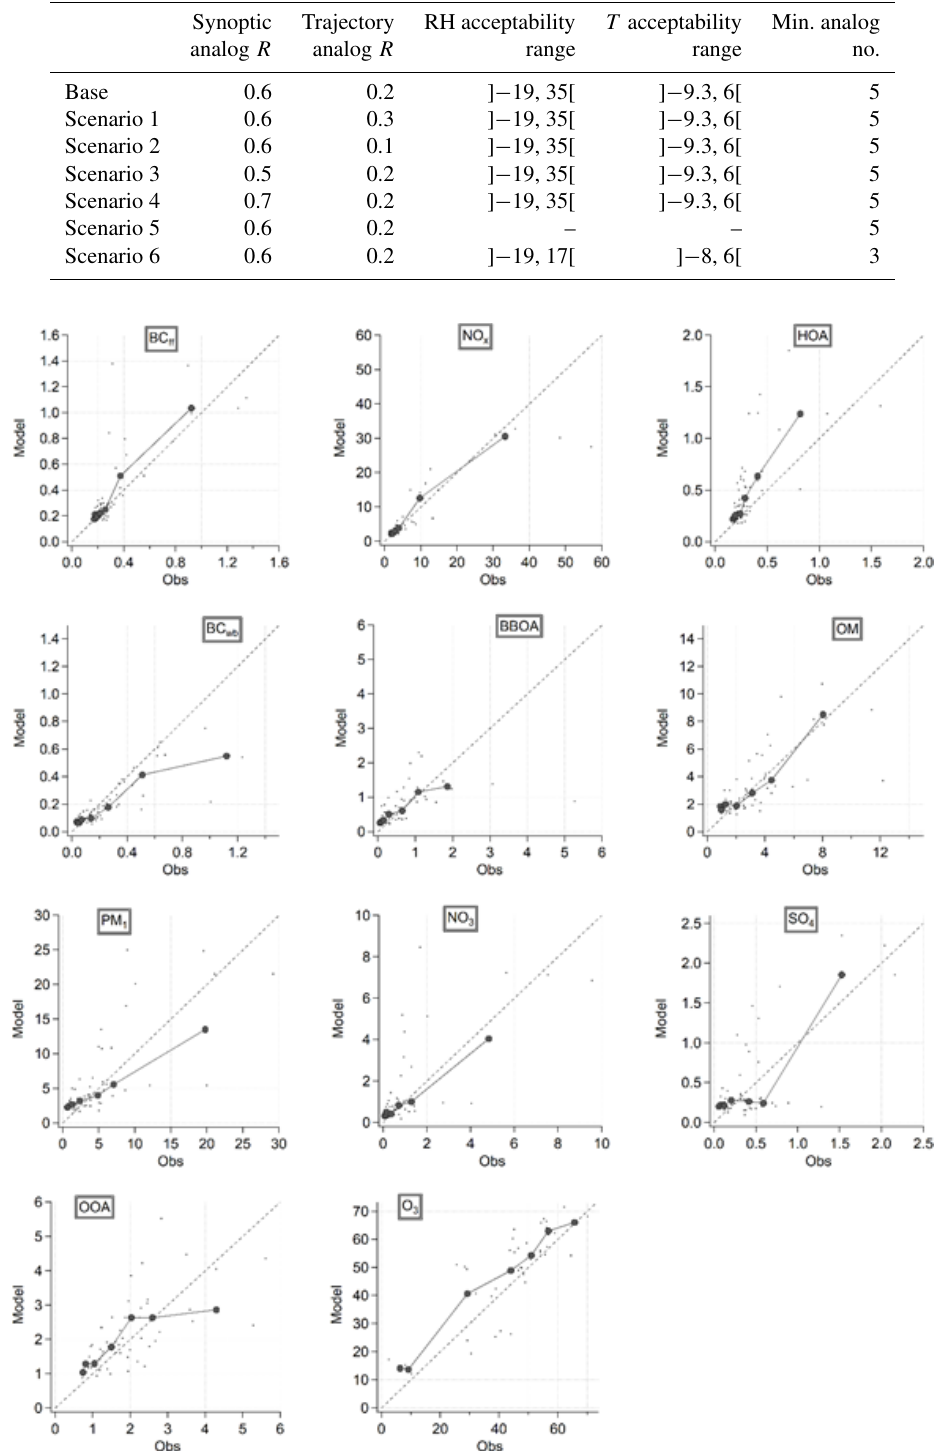
Table 2. Acceptability thresholds used in different scenarios to evaluate the sensitivity of our methodology.